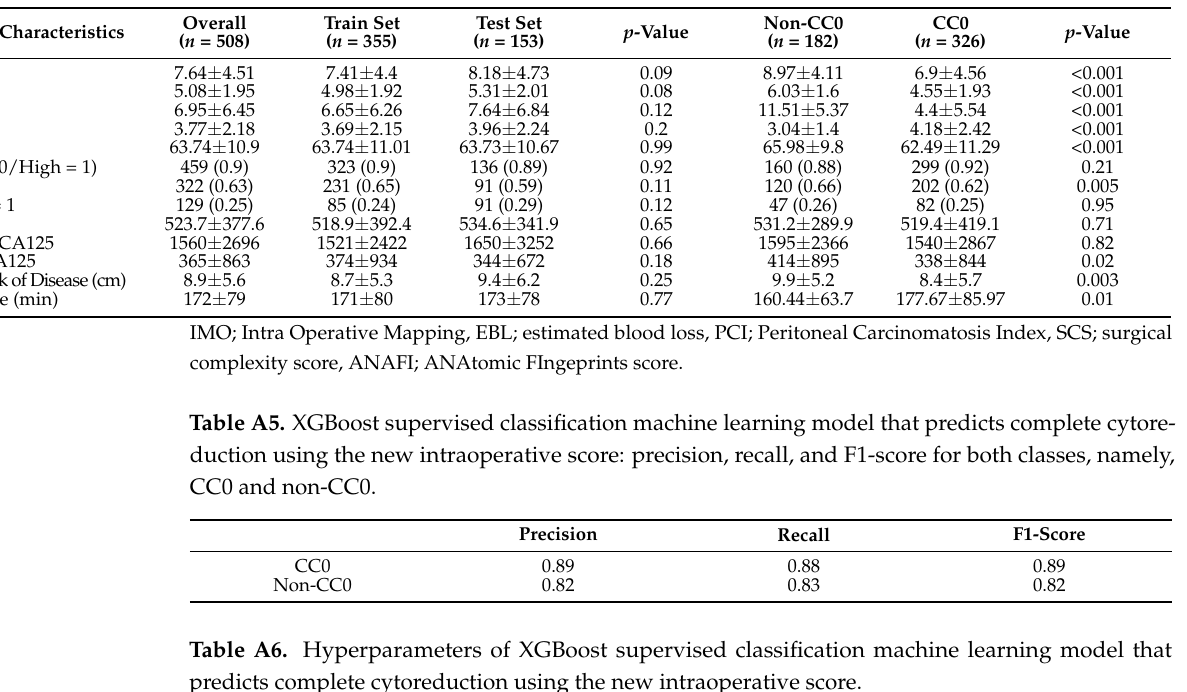
Table A4. Two Independent Sample t Test was used for continuous variables, whereas Chi-Square Test of Independence was used for categorical data. Statistical analysis was performed using Python’s SciPy library. Values are mean ± SD or n (%).